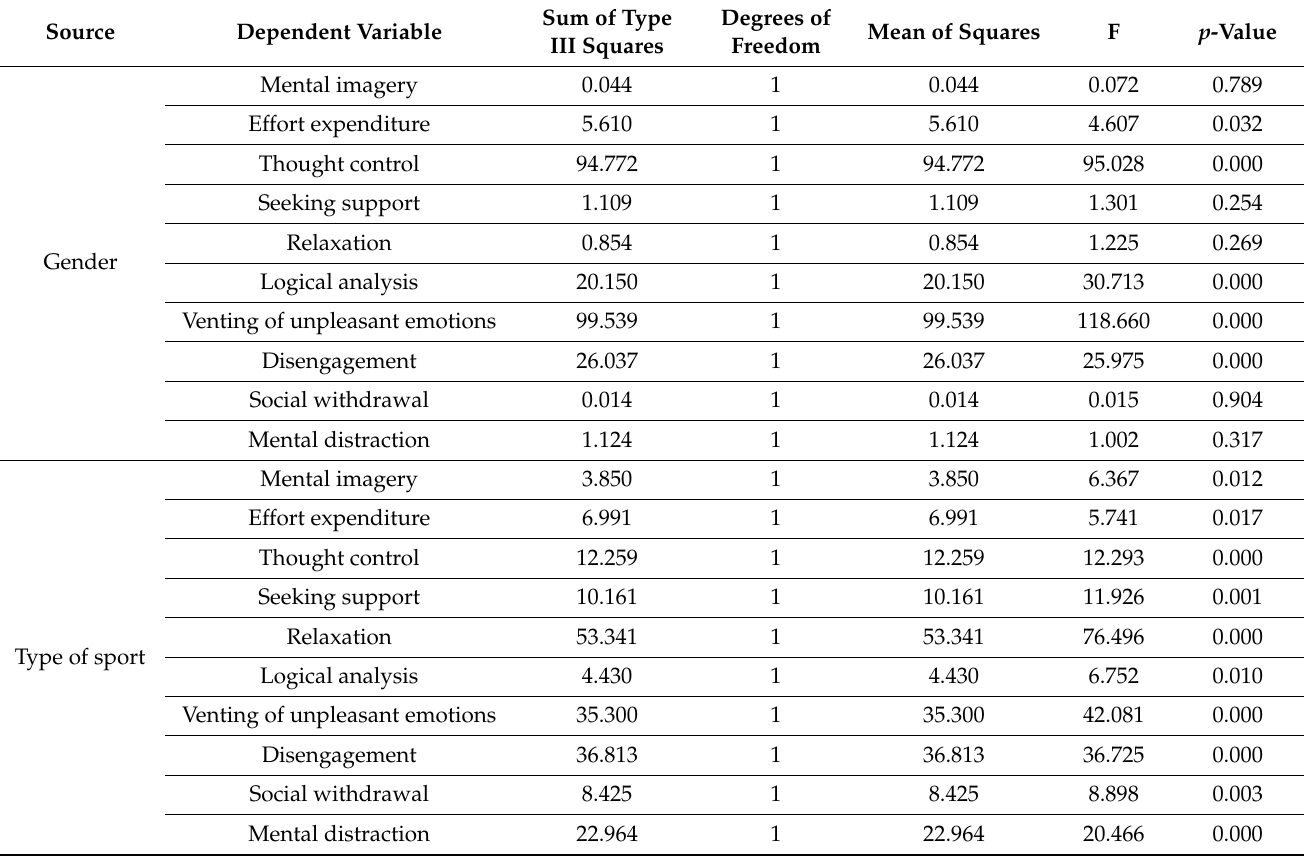
Table 2. Inter-subject interaction effects between gender and type of sport factors and the coping strategies used by young Tunisian